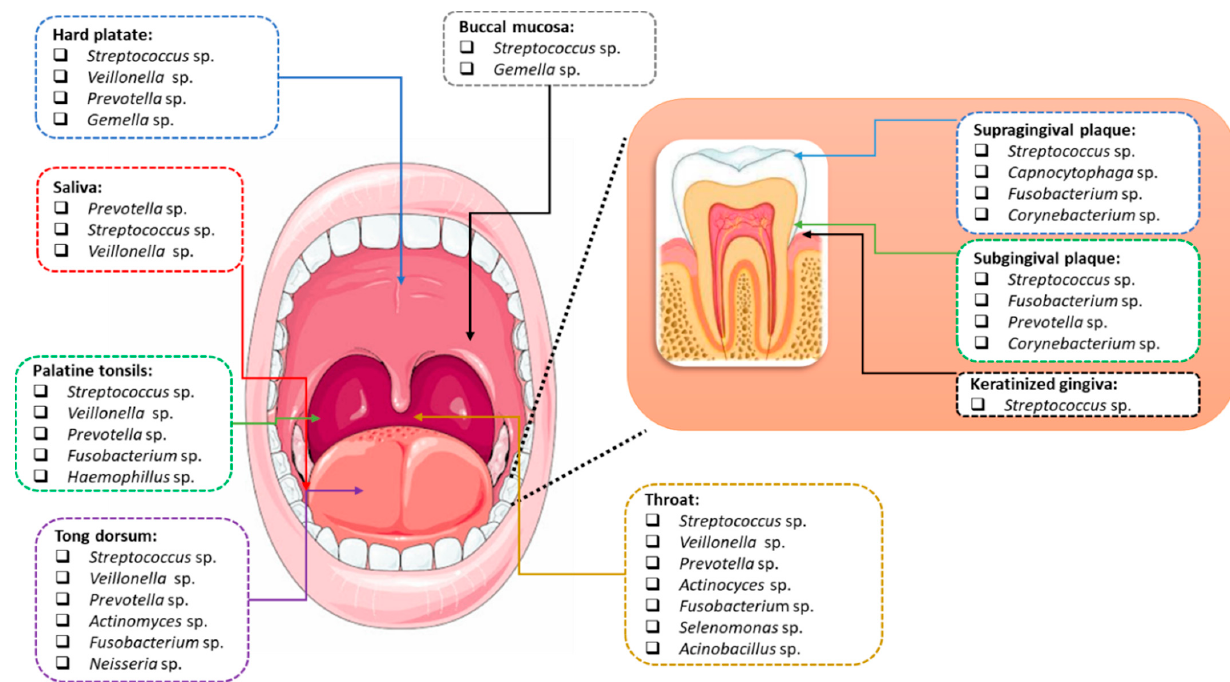
Figure 2. Differentiation of the composition of the oral microbiota depending on the niche (based on [22,23]).